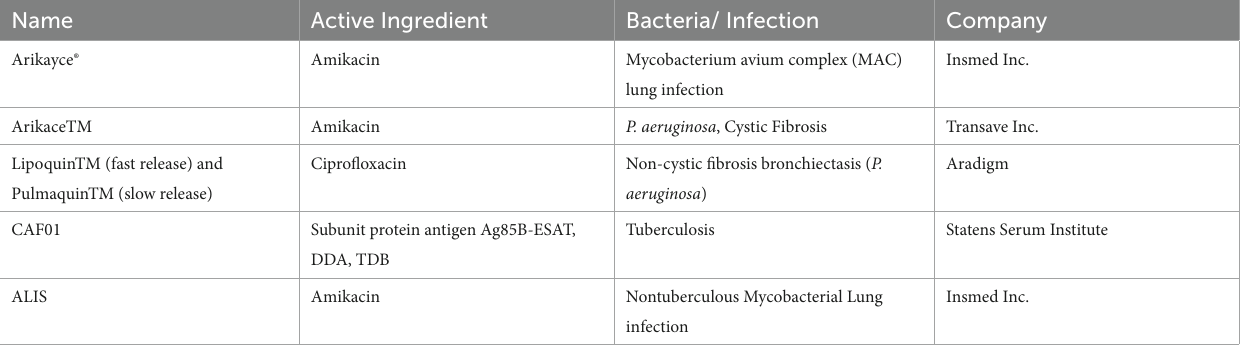
TABLE 3 FDA Approved antimicrobial